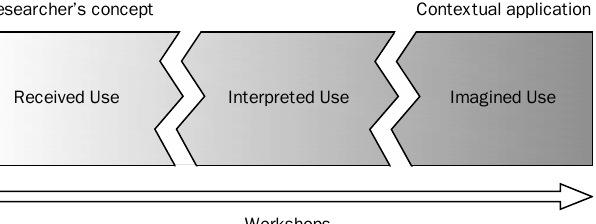
Figure 9. Prototypes move toward relevant uses through discussion in community workshops.